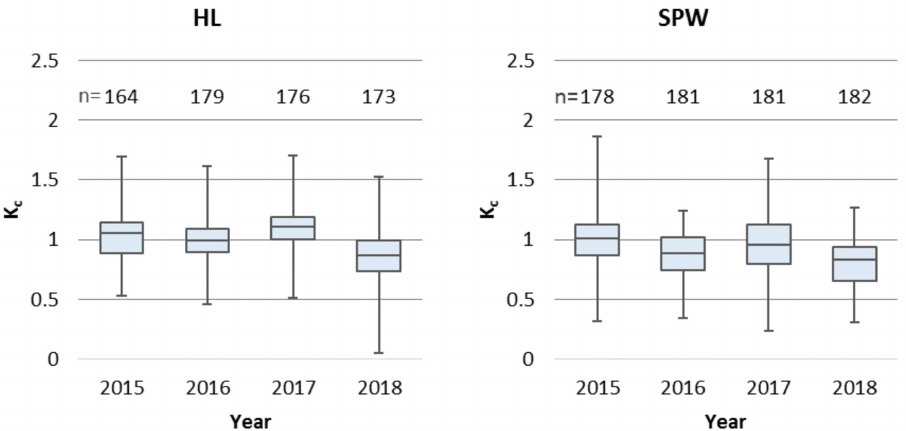
Figure 7. Whisker plots of the K c values at the Havelländisches Luch (HL) and Spreewald (SPW) sites in the vegetation period from April to September in the years 2015 to 2018 (n—number of values per vegetation